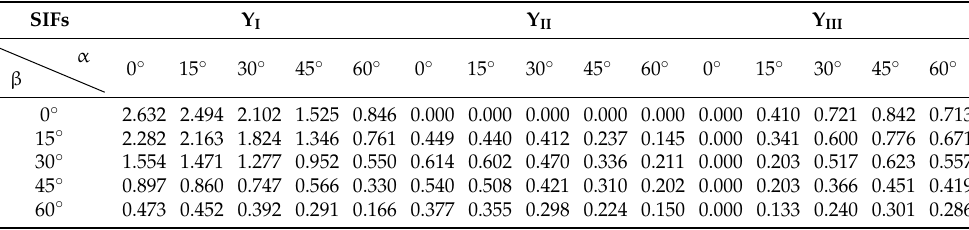
Figure 12. Variation of fracture load P ave with respect to horizontal deflection angle α and vertical deflection angle β . ( a ) The relationship between P ave and α . ( b ) The relationship between P ave and β . Table 6. Values of dimensionless SIFs at various horizontal and vertical deflection